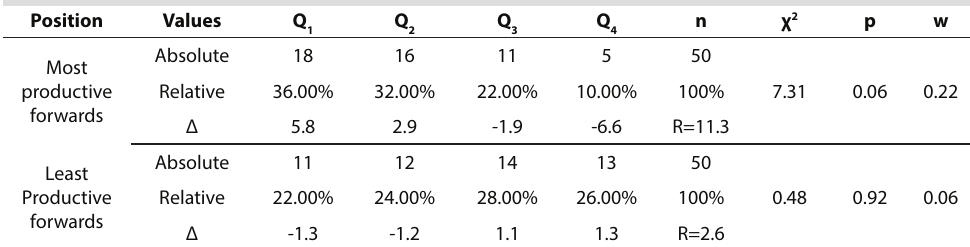
TABLE 4. Comparison of the 50 Most Productive and the 50 Least Productive Forwards